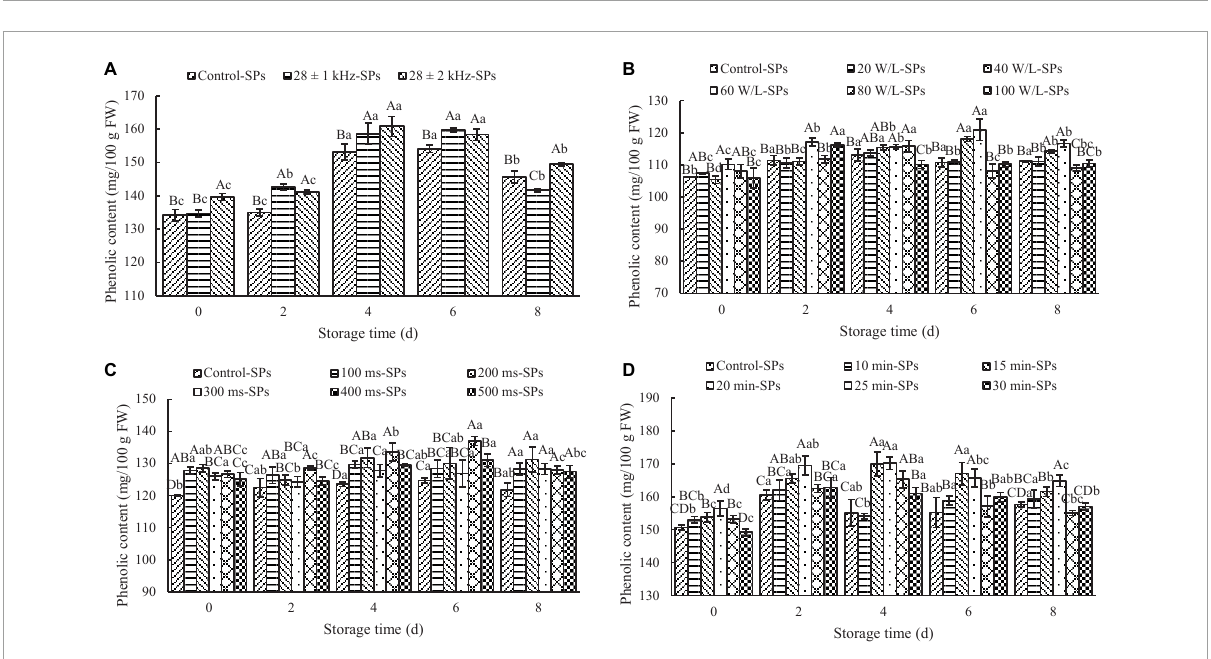
FIGURE3 Effects of ultrasonic power density, frequency amplitude, frequency cycle time, and ultrasonic time on the content of soluble phenolics (SPs). The results represent the means of three triplicates ± standard deviations. Different capital letters mean that the effects of different treatments for the same day are significantly different ( P < 0.05); different lowercase letters mean that the effects of storage times for the same treatment are significantly different ( P < 0.05). (A) Frequency amplitude; treatment: ultrasonic power density of 60 W/L, frequency cycle time of 500 ms, and ultrasonic time of 15 min. (B) Ultrasonic power density; treatment: ultrasonic frequency mode of 28 ± 2 kHz, frequency cycle time of 500 ms, and ultrasonic time of 15 min. (C) Frequency cycle time; treatment: ultrasonic frequency mode of 28 ± 2 kHz, ultrasonic power density of 60 W/L, and ultrasonic time of 15 min. (D) Ultrasonic time; treatment: ultrasonic frequency mode of 28 ± 2 kHz, ultrasonic power density of 60 W/L, and frequency cycle time of 400 ms. Control: fresh-cut red cabbages were washed with sterile distilled